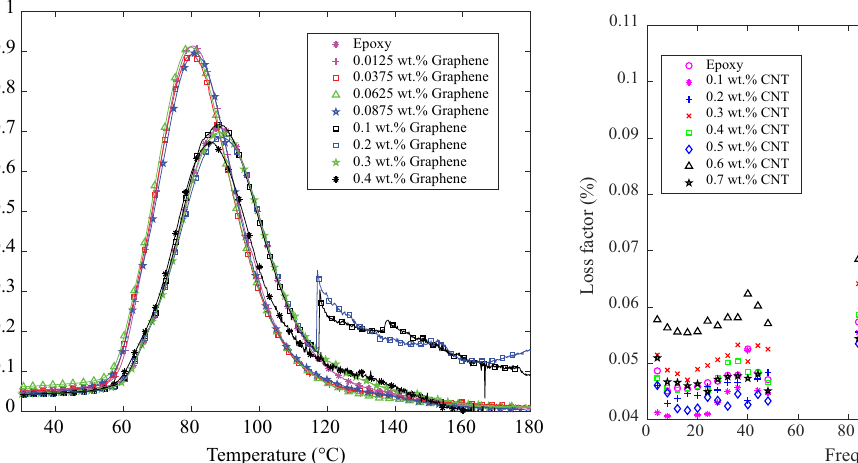
Figure 7: Frequency - dependent loss factor of CNT - reinforced com - posites by DMA tests.